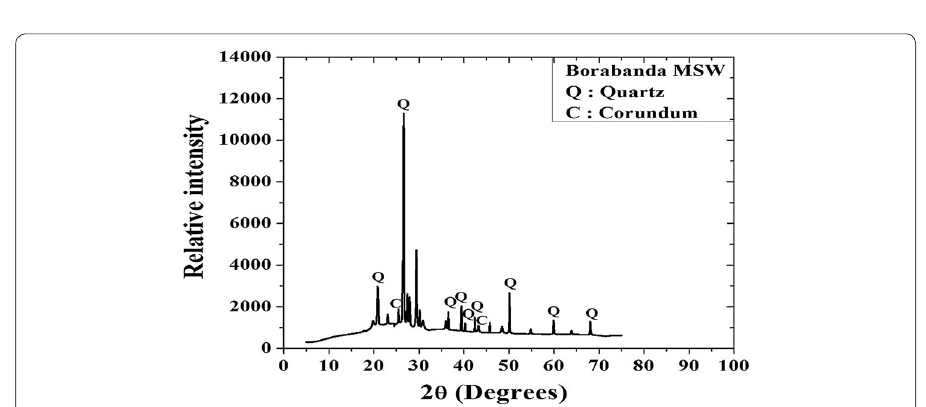
Fig. 6 X-ray diffraction pattern for Borabanda